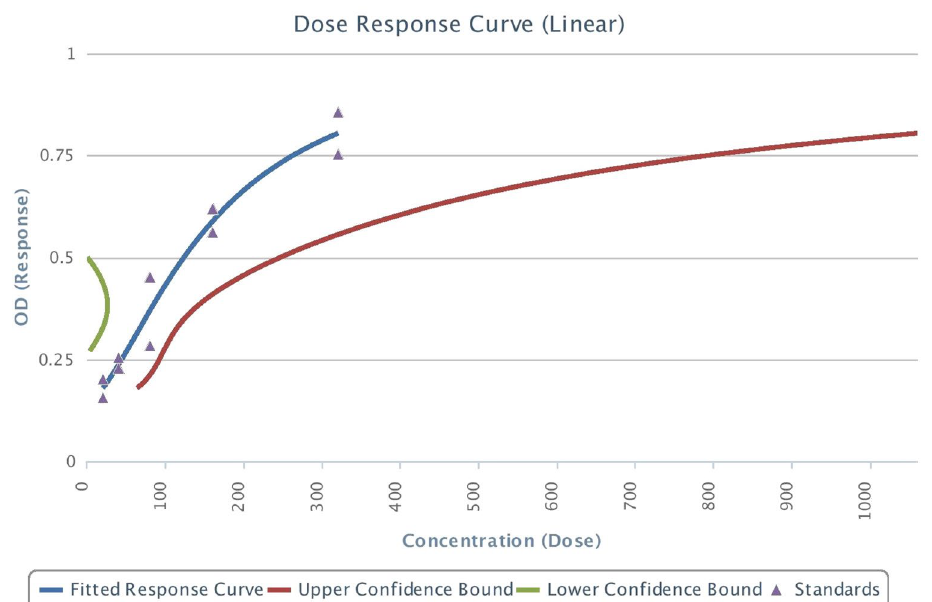
Figure 6. CGRP analysis by 4-parametric logistic regression curve analysis with commercially available